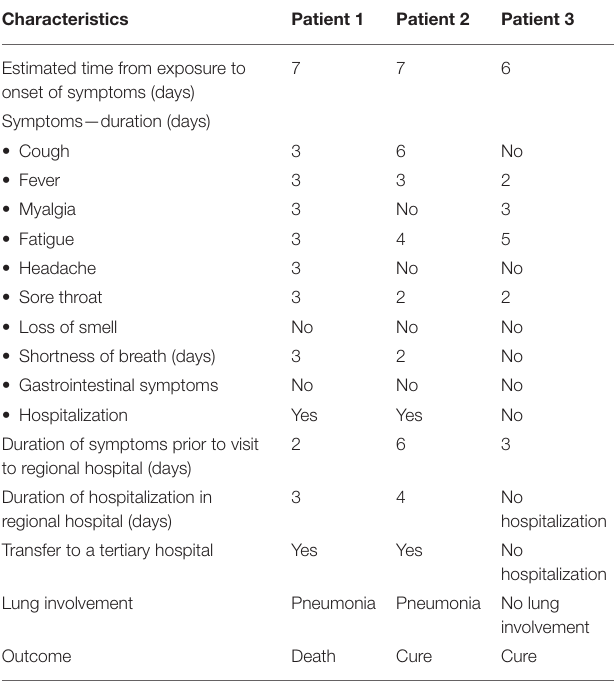
TABLE 1 | The clinical characteristics of the first three patients with COVID-19 diagnosed in a Greek regional hospital.